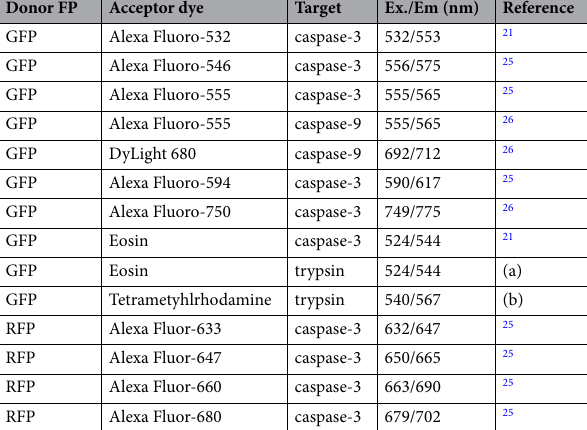
Table 1. Bioprobes already reported. Composition of some bioprobes previously generated were extracted to show high adjustabilities. (a) Suzuki, M., Ito, Y., Savage, H.E., Husimi, Y. & Douglas, K.T. Biochim Biophys Acta. 1679, 222–229 (2004). (b) Suzuki, M., Ito, Y., Savage, H.E., Husimi, Y. & Douglas, K.T. Saitama Univ. Bulletin Dept. of Eng. 37, 29–37